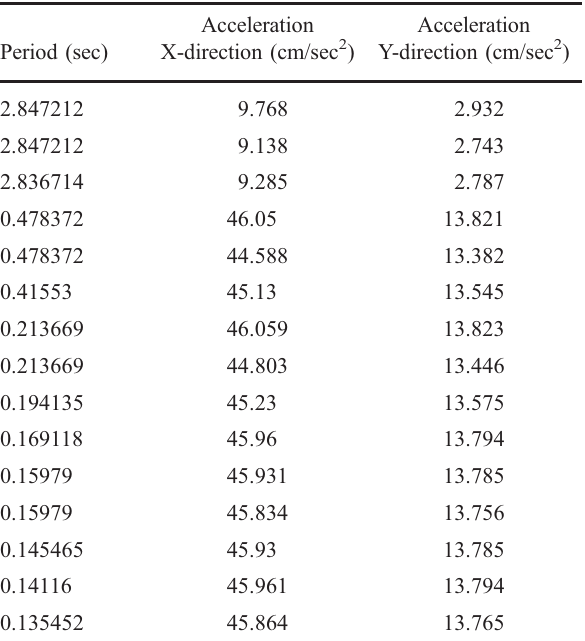
Table 9. Frequency domain modal acceleration for varying period (isolated building)